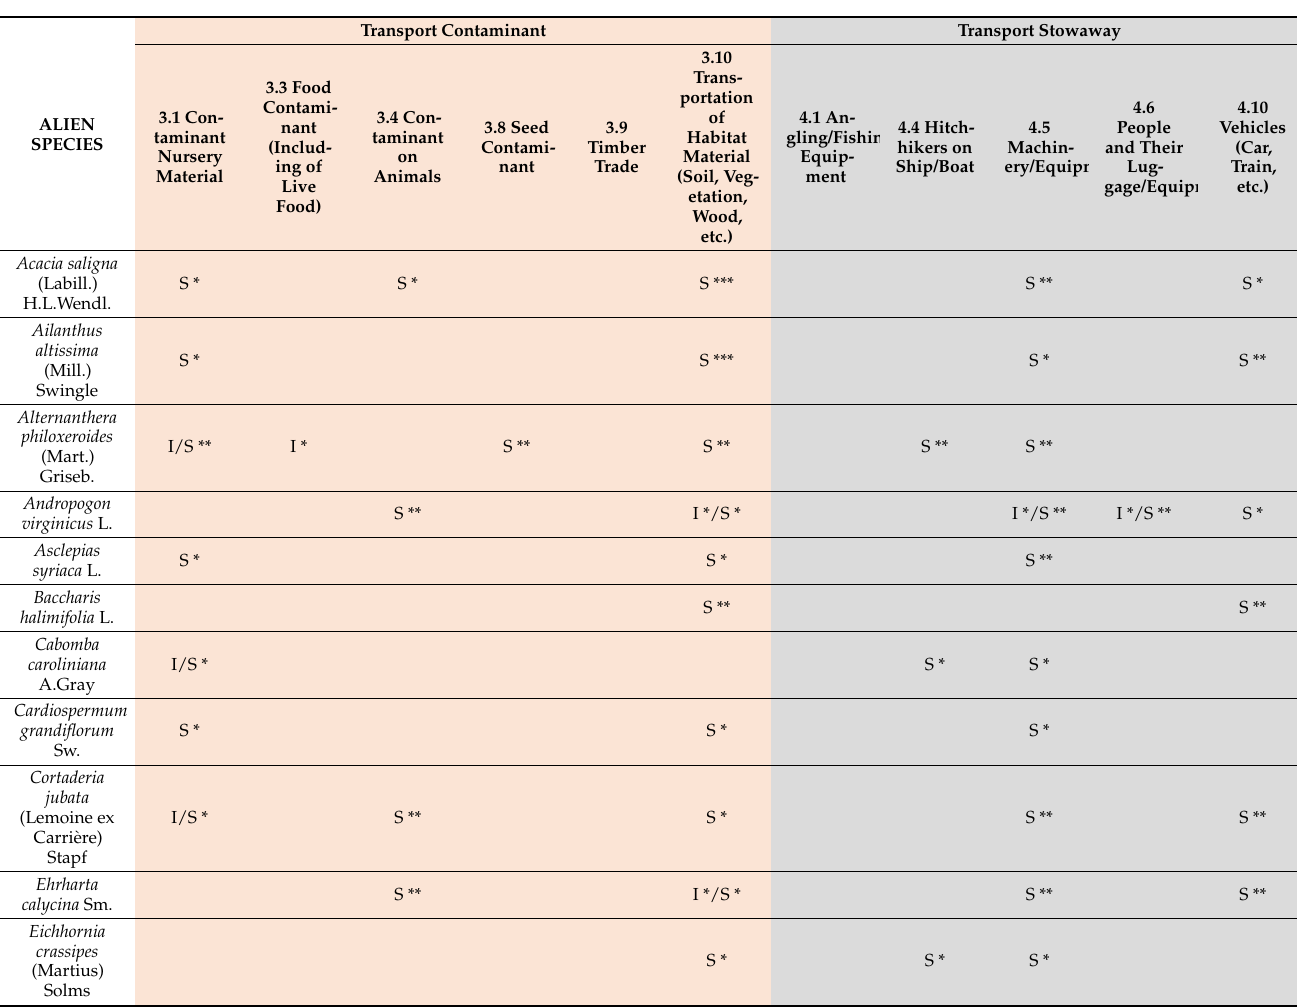
Table 3. Accidental human-mediated pathways of introduction (I) and spread (S) of IAPUC in the EU (the likelihood of a given pathway for a species is indicated with one or more asterisk (* = low likelihood, ** = medium likelihood, *** = high